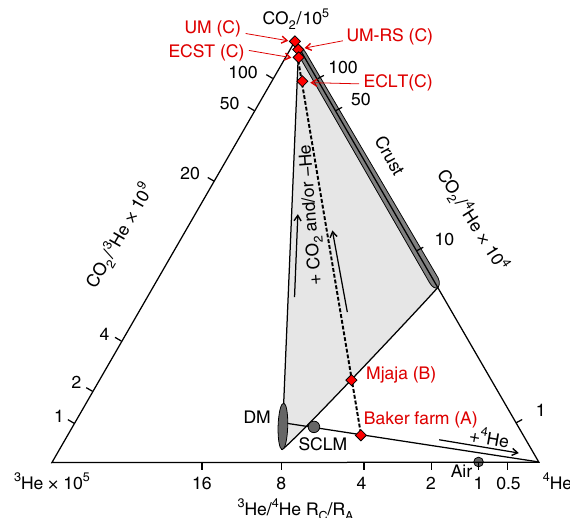
Fig. 2 CO 2 / 3 He against δ 13 C for the Bongwan CO 2 samples. Individual samples are plotted as red circles along with labels outlining their associated air-corrected 3 He/ 4 He c in R A (where R A is the atmospheric 3 He/ 4 He of 1.399 × 10 − 6 ) and their location corresponding to Fig. 1 (A – Baker Farm, B – Mjaja and C – Umtamvuna). Mixing lines (black lines and grey shading) are shown for CO 2 derived from the mantle, limestone and organic sediments 38 . End-member compositions cover the range of values 38,62 (mantle CO 2 / 3 He = 1 – 10 × 10 9 ; mantle δ 13 C = − 9 to − 4 ‰ ; Crustal CO 2 / 3 He = 1 × 10 12 – 10 14 ; Limestone δ 13 C = 0 ± 2 ‰ ; Organic sediment δ 13 C = − 30 ± 10 ‰ ). The range of δ 13 C values for South African carbonate sources from the Marble Delta 20 , Matjies River Formation 20 , and the Transvaal Supergroup 66 are provided. The extent of δ 13 C CO2 that would be produced by acid groundwater dissolution of Marble Delta Formation carbonate is also shown (grey box and black lines depicting the minimum δ 13 C CO2 that would result from dissolution of the formation carbonate between 10 °C (left) and 100 °C (right)) (see Methods). The trend between CO 2 / 3 He and δ 13 C CO2 are consistent with the mixing of mantle-derived CO 2 with CO 2 derived from the overlying Marble Delta Formation carbonates at up to 70 °C (see “ Methods ” ). δ 13 C CO2 was not measured from the sample collected at the Umtamvuna River Spring and hence